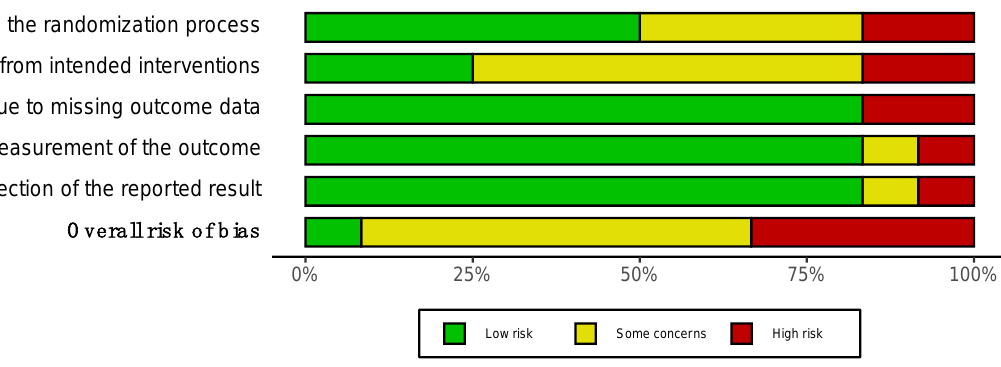
Figure 2. Risk of bias of the studies included in the systematic review.